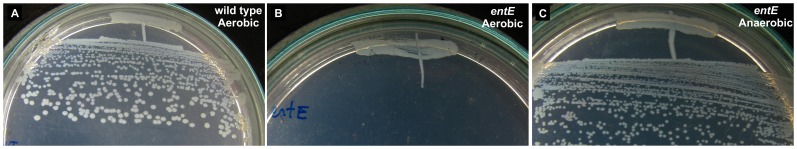
Growth of E. coli wild-type and entE mutant streaked in M9A.Wild-type strain growth in aerobic conditions (A) and entE mutant growth in aerobic (B) or anaerobic conditions (C).